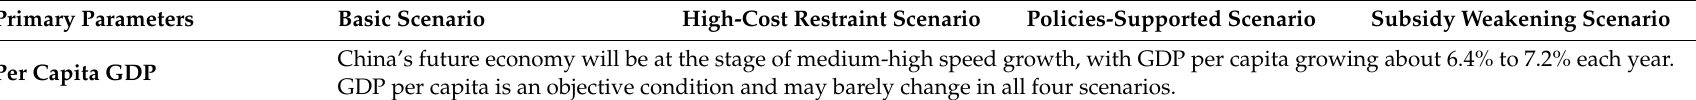
Table 6. Scenarios and primary parameter